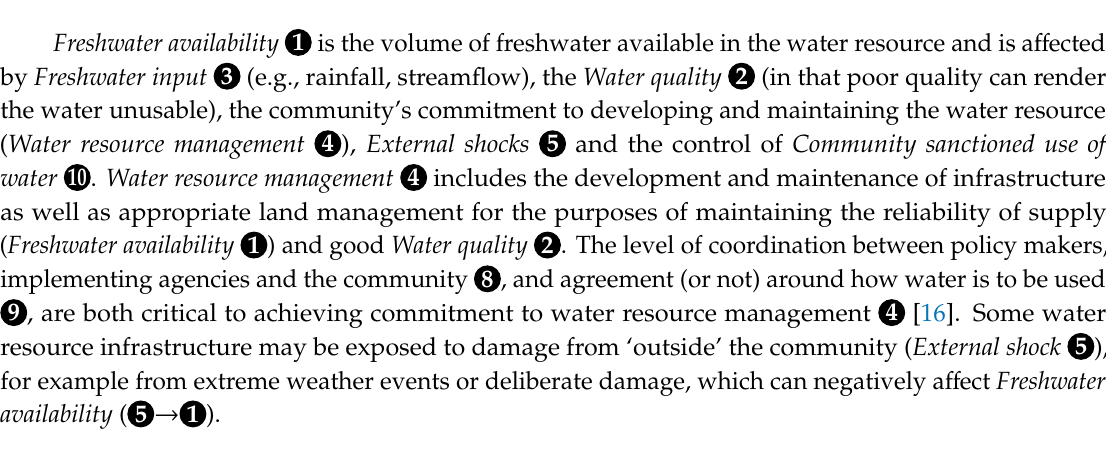
Figure 4. The local water management framework showing the core structure of the framework (concepts in the white boxes) and the concepts that describe the pathways to the core concepts (black text not in a box). For all concepts, definitions or relative importance may differ between people, groups or locations. The concepts are related to the freshwater resource (blue), community dynamics (yellow), the local water institution (orange), and the individual actor’s access to water (green). (i)